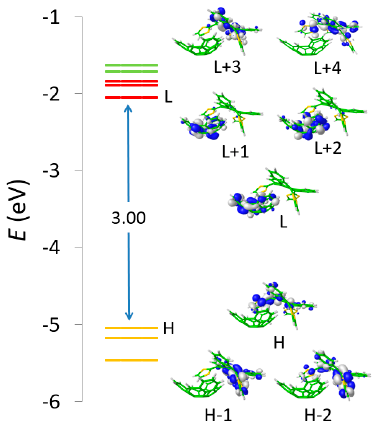
Figure 19. Isovalue contours (± 0.03 a.u.) and energies calculated for the HOMOs and LUMOs of structure A4 at the revPBE0-D3/cc-pVTZ level. H and L denote HOMO and LUMO, respectively. Adapted with permission from [18]. Copyright 2014 WILEY-VCH Verlag GmbH & Co. KGaA.